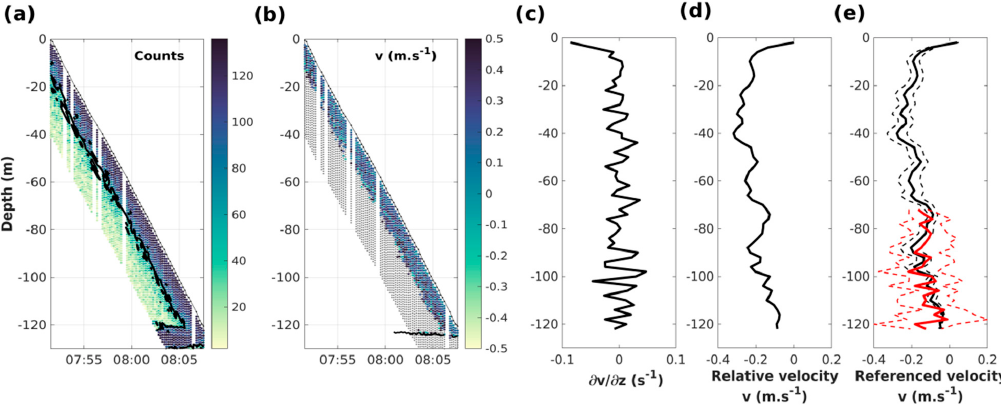
Figure 4. Example of measurements carried out by the ADCP during a descent of the glider. ( a ) Swath of the counts signal for each cell of successive water profiles. The empirical threshold of 64 counts used to discard erroneous velocity values is shown in black. ( b ) Filtered raw northward velocity measurements (m s − 1 ). Discarded values are shown in gray. The black line shows bottom detection. ( c ) Mean profile reconstructed after stacking the successive profiles of the vertical derivatives of measured currents. ( d ) Integrated relative velocity profile. ( e ) Absolute velocity profile (black line) after adjustment with near-bottom current measurements derived from bottom tracking (red line); dashed lines indicate uncertainties (standard deviation) for each variable.